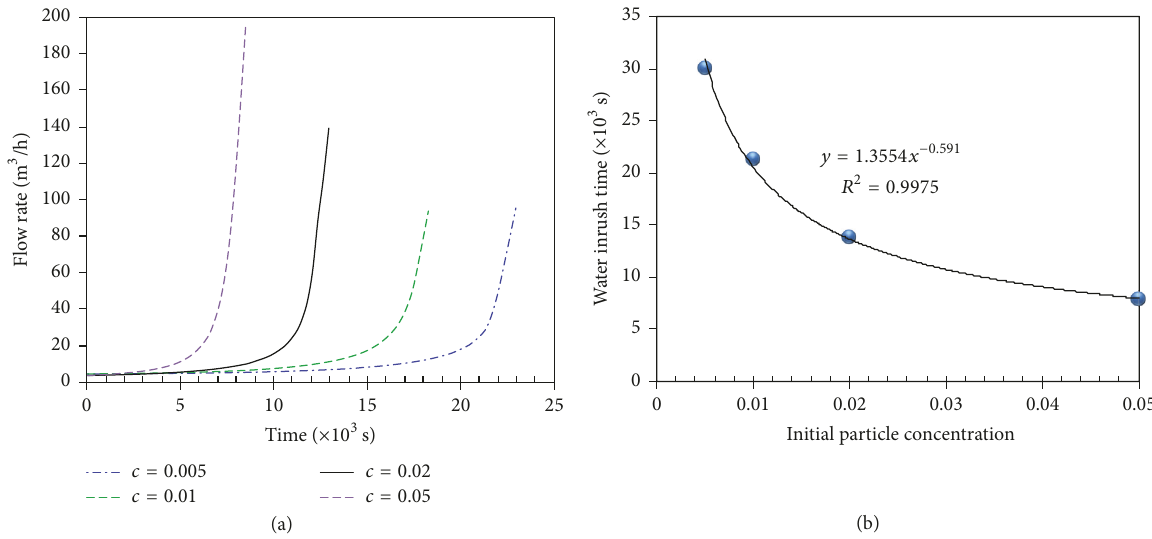
Figure 26: Impact of initial particle concentration on water flow rate (a) and inrush time (b).